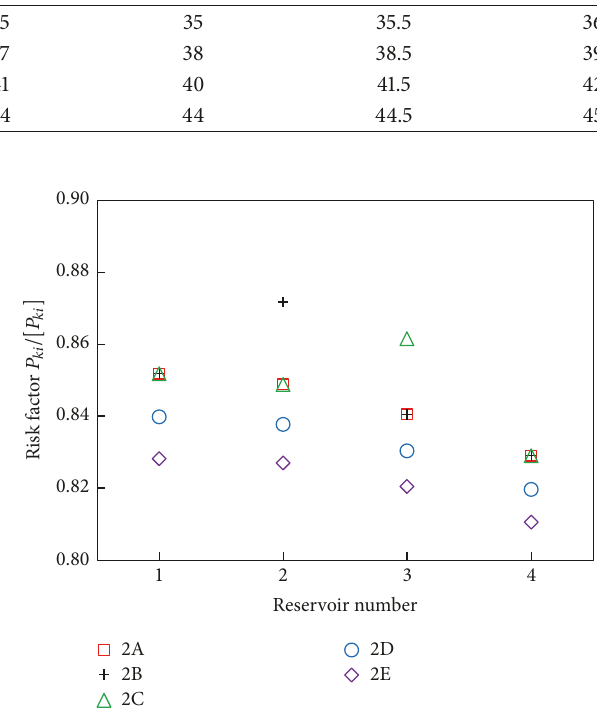
Figure 6: Variations in the risk factors of the reservoirs at differ- ent formation-fracturing pressures for the conceptual engineering